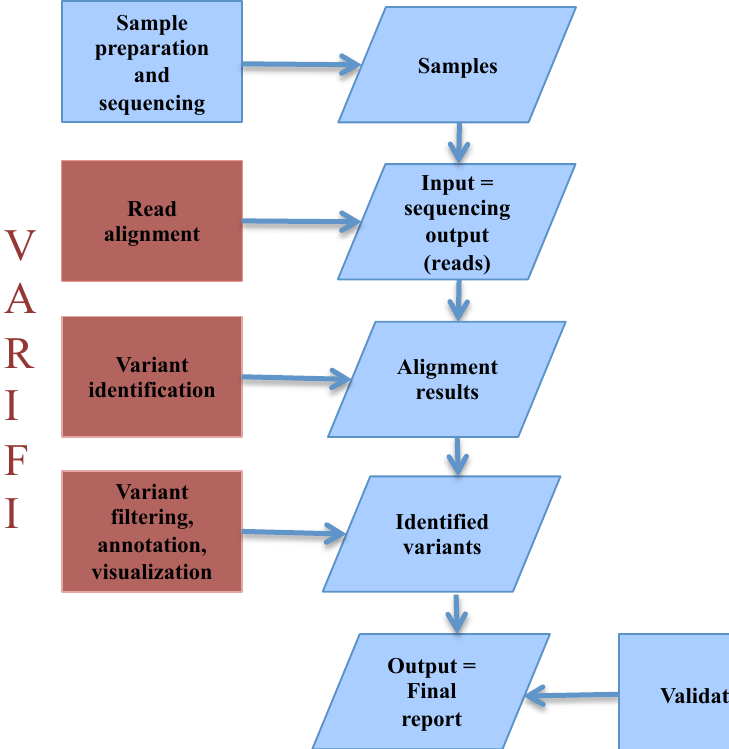
Figure 1. Complete variant analysis workflow from the sample preparation to the variant validation. Processes are presented using rectangles: VARIFI processes are in red, and laboratory experiments which we used to develop and optimize VARIFI are in blue rectangles. Parallelograms show input/output data of these processes. Arrows show the process and data generation flow. After sample preparation and sequencing, VARIFI starts by aligning the reads against the human genome reference and continues with variant identification in the alignment results. Detected variants are then filtered, annotated and prepared for visualization. VARIFI output is a list of filtered and annotated variants displayed in a final report. We used variant validation to optimize and evaluate VARIFI